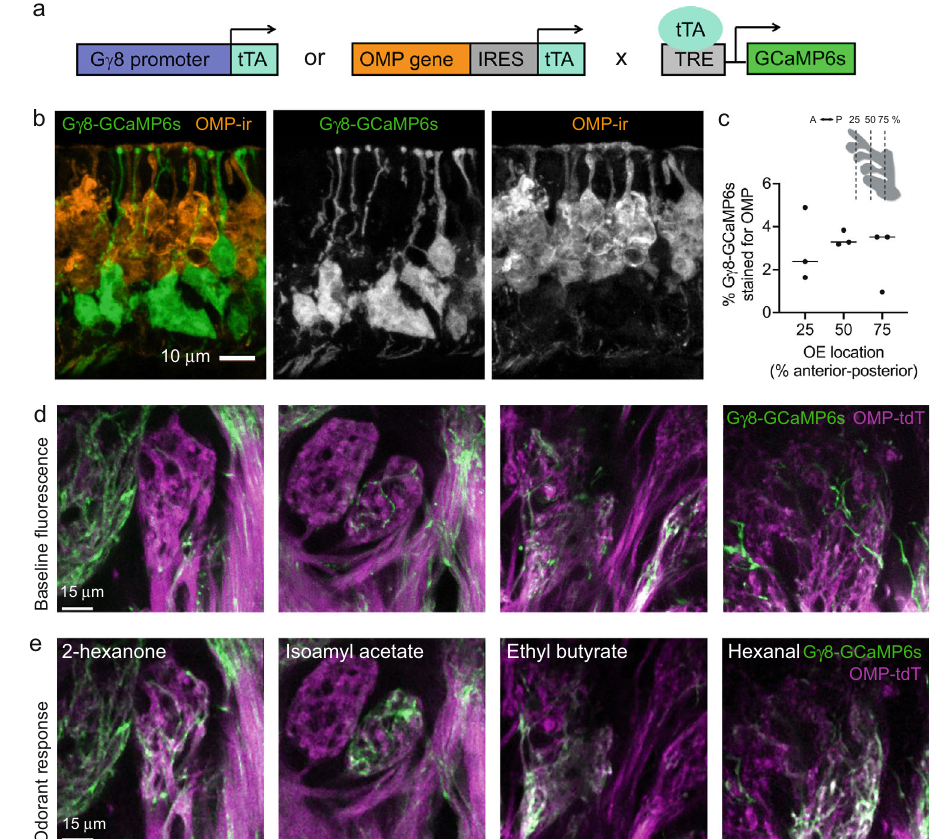
Fig. 1 | G γ 8-GCaMP6s mice enable selective imaging of immature OSN axon odorant responses in glomeruli. a Schematic of breeding strategy to generate miceexpressingGCaMP6sineitherimmatureormatureOSNsundercontrolofthe G γ 8 or OMP promoter, respectively, using the tetracycline transactivator system. b MIP of confocal z-stack of coronal OE section from a G γ 8-GCaMP6s mouse showing lack of colocalization with OMP-stained OSNs. c Co-expression of OMP (OMP-ir) in G γ 8-GCaMP6s-expressing OSNs in the septal olfactory epithelium (OE) along the anterior-posterior(A-P) axis.Only3.0±1.2%of G γ 8-GCaMP6s-expressing